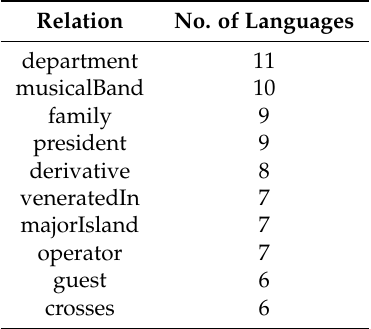
Table 8. Most frequently extracted relations across the top 12 languages.